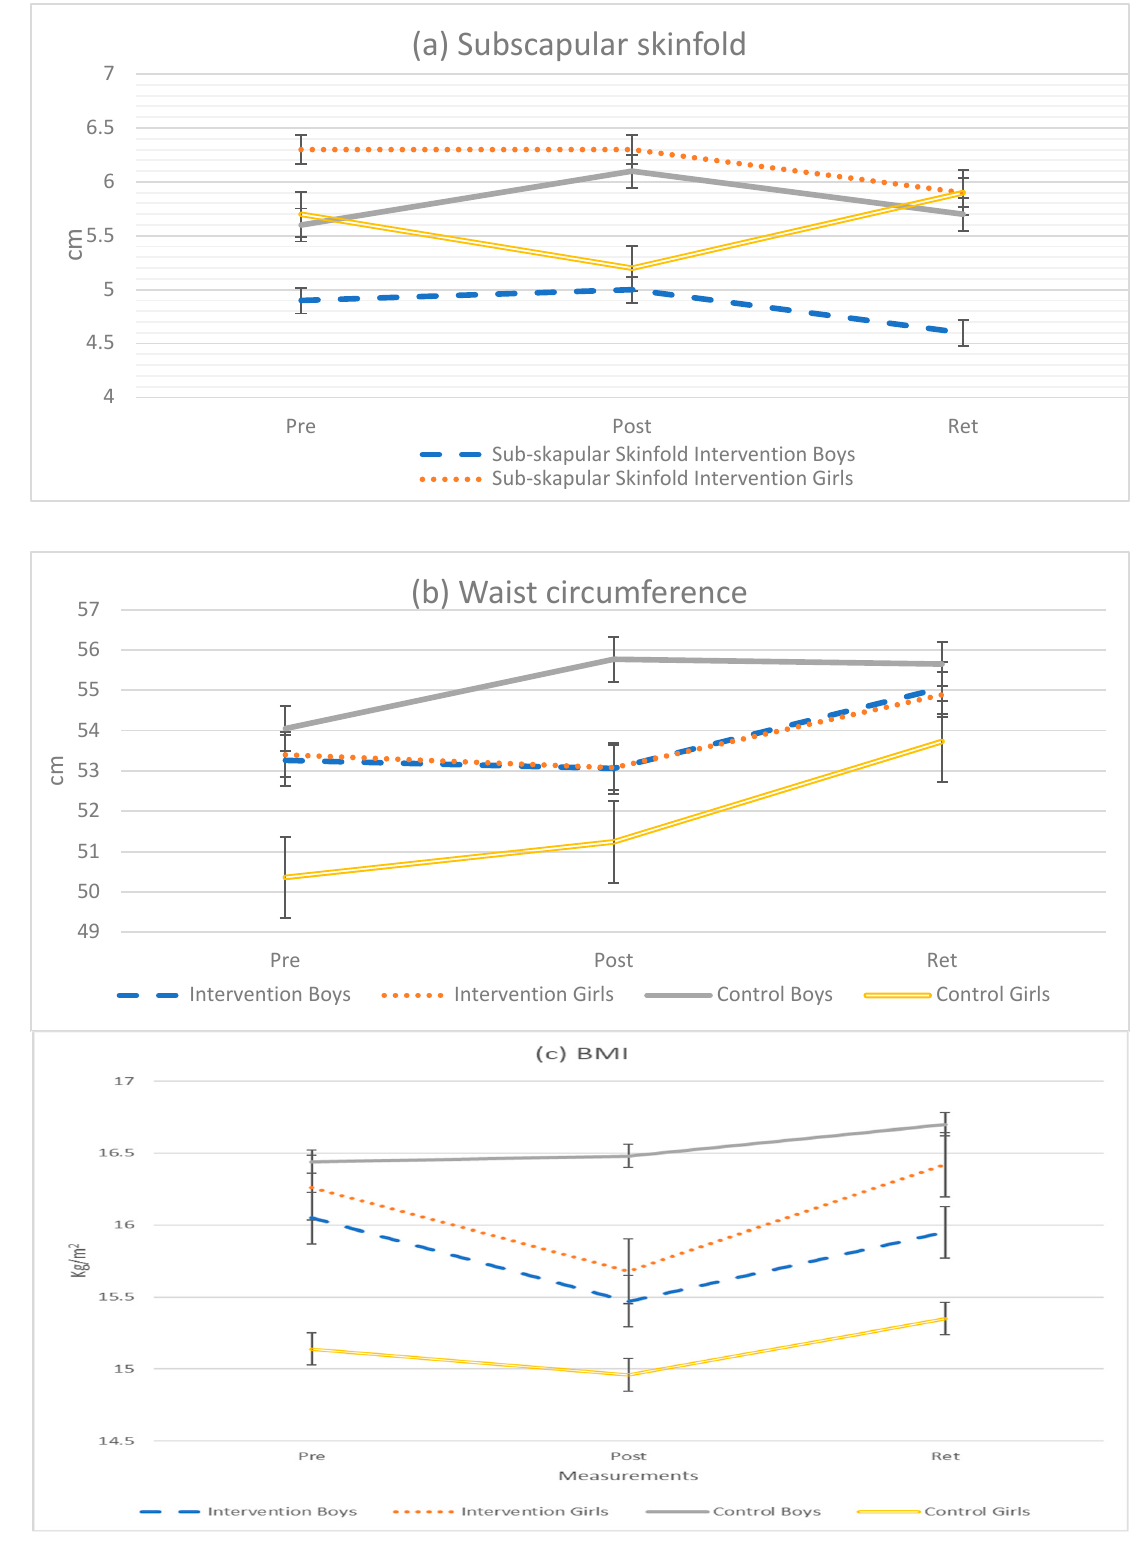
Figure 2. ( a – c ) Anthropometrics variables of participants according to sex, group and time. In all the anthropometrics variables, the subscapular skinfold and BMI showed imme- diate and sustainable effects while the waist circumference showed an immediate effect in the intervention group relative to the control